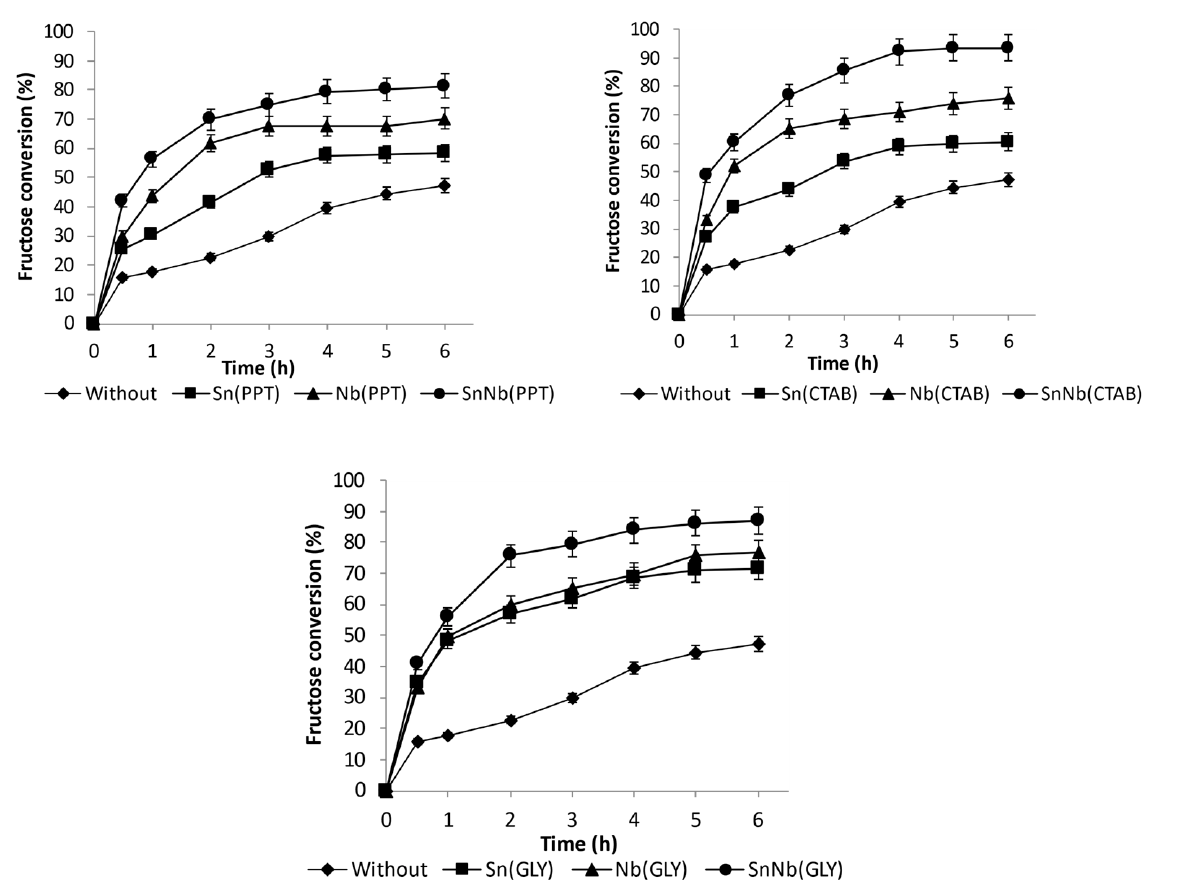
Figure 8. Fructose conversion at 150 °C using Sn(PPT), Nb(PPT) and SnNb(PPT); Sn(CTAB), Nb(CTAB) and Nb(GLY) and SnNb(CTAB); and Sn(GLY), Nb(GLY) and SnNb(GLY).